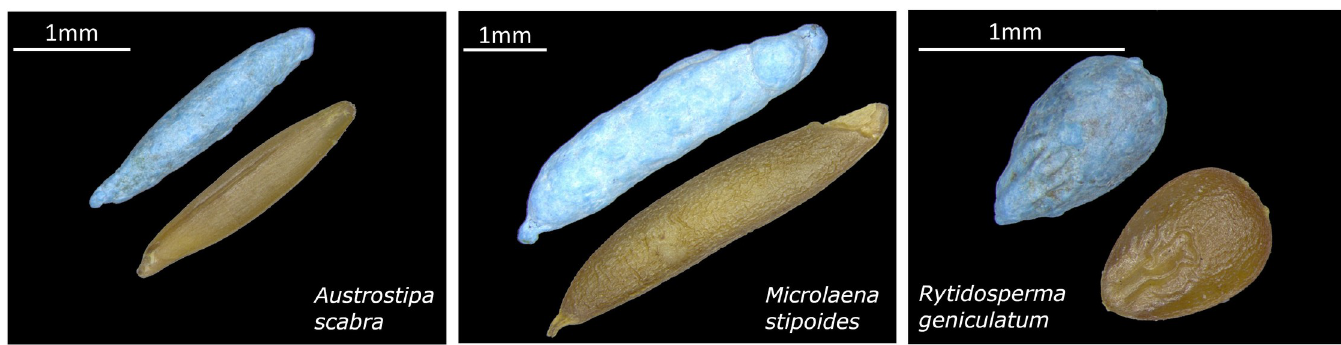
Fig 1. Seeds of the three grass species tested. Each image shows encrusted (blue) and untreated-imbibed seeds. Scale bars indicate seed